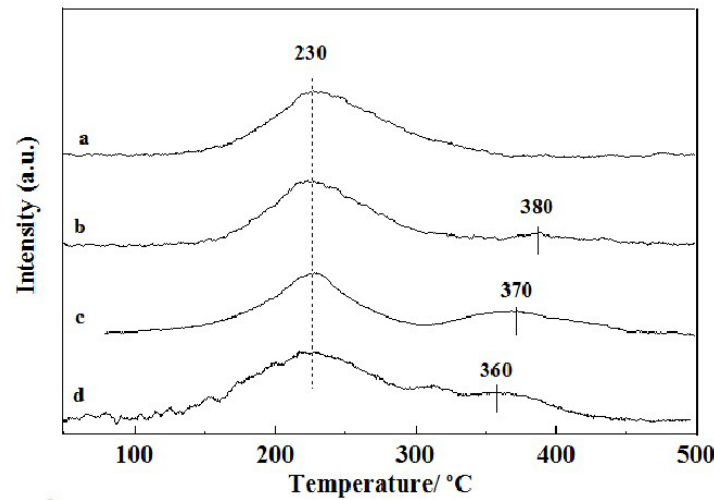
Figure 5. Temperature programmed oxidation of catalysts. ( a ) Cat-fresh, ( b ) Cat-used-150, ( c ) Cat- used-300 and ( d ) Cat-used-450.